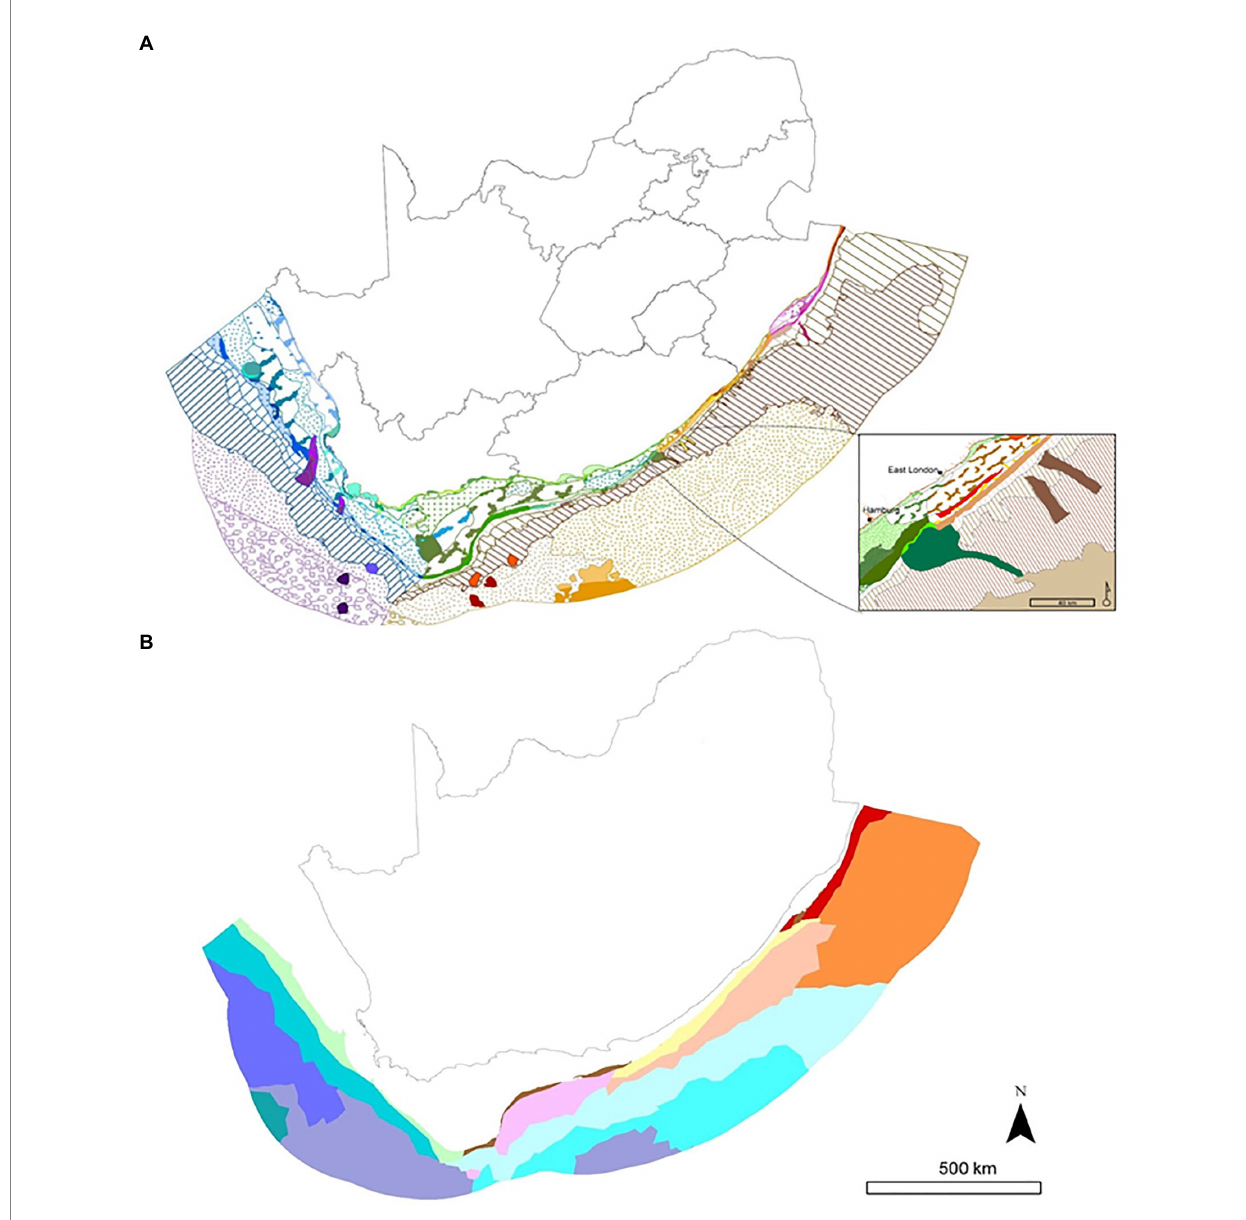
FIGURE 5 Map of the 163 marine ecosystem types in South Africa, including (A) 128 combined bentho-pelagic (shelf) and 22 deep-sea benthic (deep-sea) types and (B) 13 deep-sea pelagic types. The insert on A shows the transition between the Agulhas (green colors) and Natal ecoregions (warm colors). The key is available in Sink et al. (2019) and the map can be explored at this https://aniday.maps.arcgis.com/apps/webappviewer/index.html?id=d123de04d